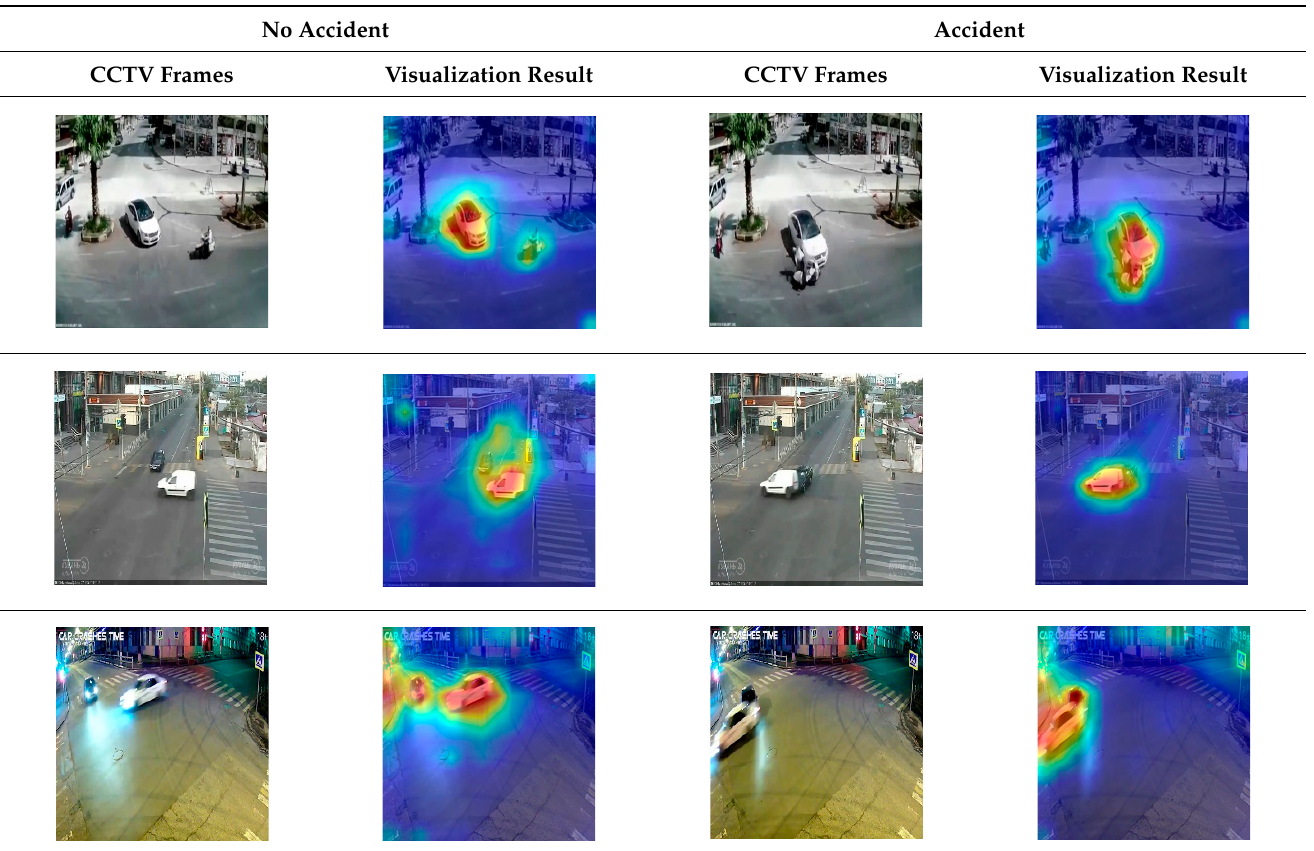
Table 5. Visualization results of ViT in CCTV frames.